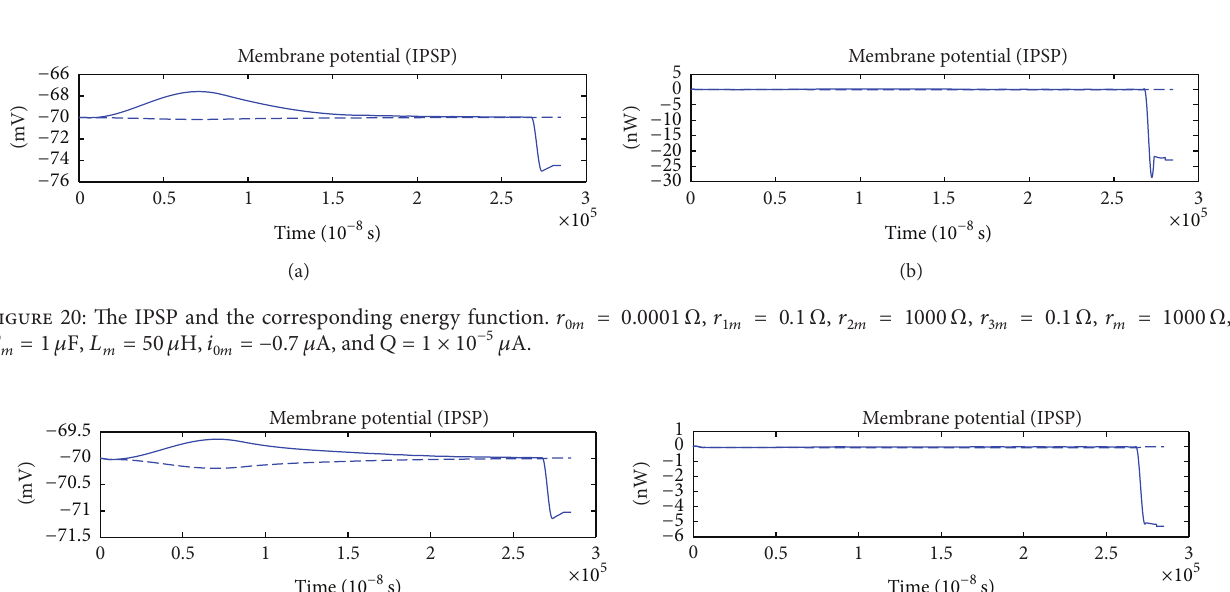
Figure 19:TheIPSP and thecorrespondingenergy function. 𝑟 0𝑚 = 0.0001 Ω , 𝑟 1𝑚 = 0.1 Ω , 𝑟 2𝑚 = 1000 Ω , 𝑟 3𝑚 = 0.1 Ω , 𝑟 𝑚 = 1000 Ω , 𝐶 𝑚 = 1 𝜇 F, = 50 𝜇 H, 𝑖 = −0.7 𝜇 A, and 𝑄 = 1 × 10 −4 𝜇 A. 𝐿 𝑚 0𝑚